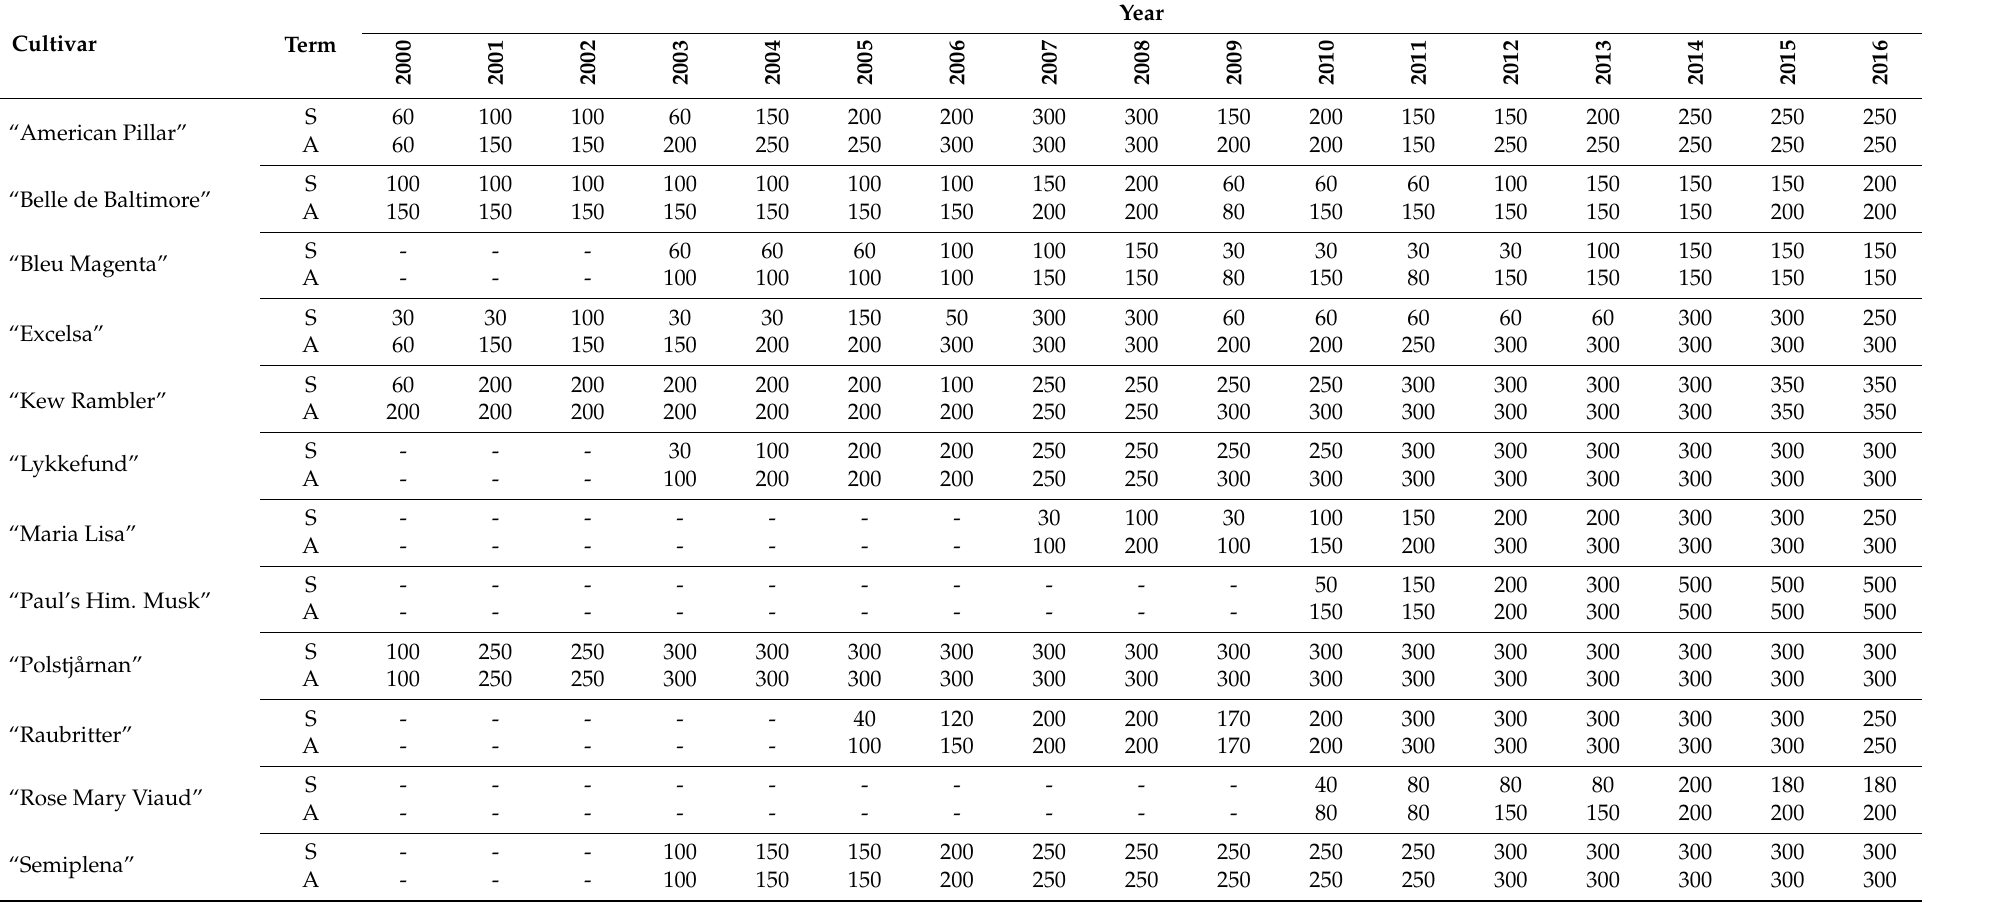
Table 10. The height (cm) of shrubs of rambler roses after spring pruning (S) and at the end of October